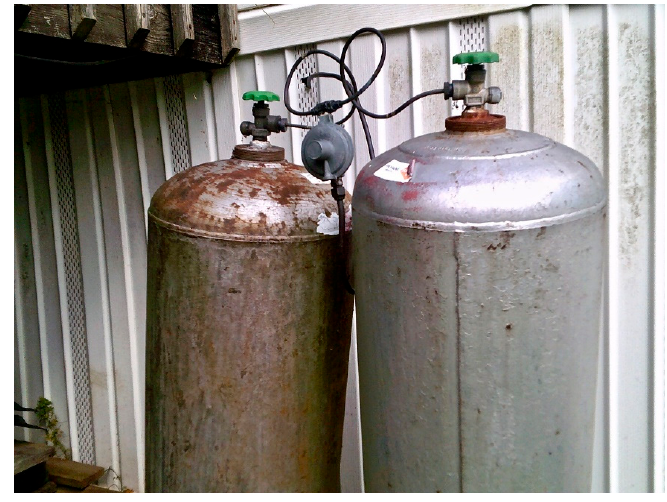
Figure 7. Propane tanks . Figure 7. Propane